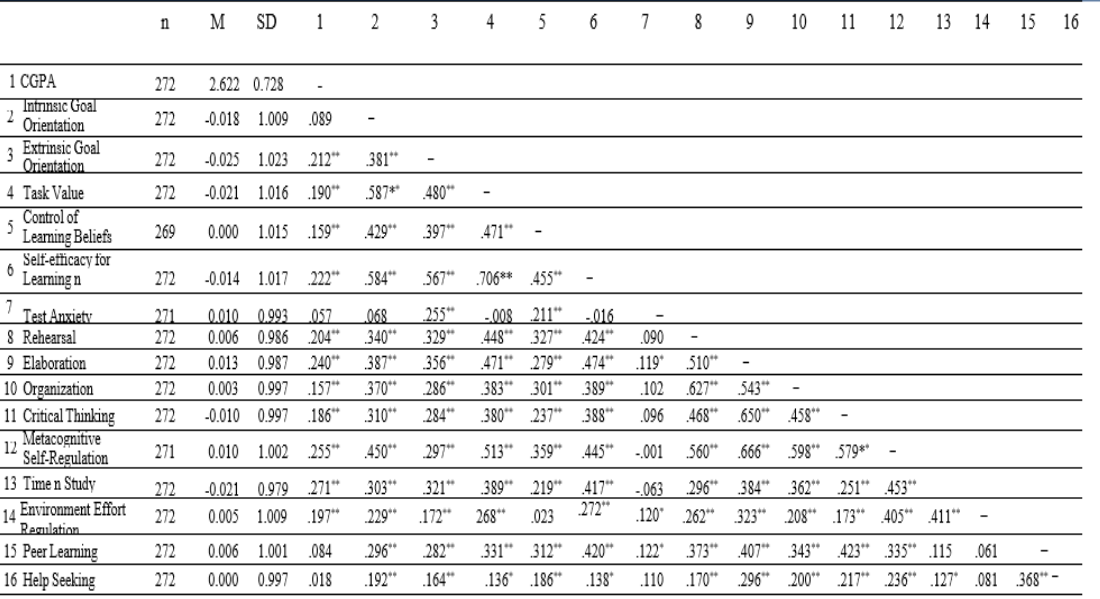
Table.5. Correlations Between Subscales And CGPA With Standard Deviation